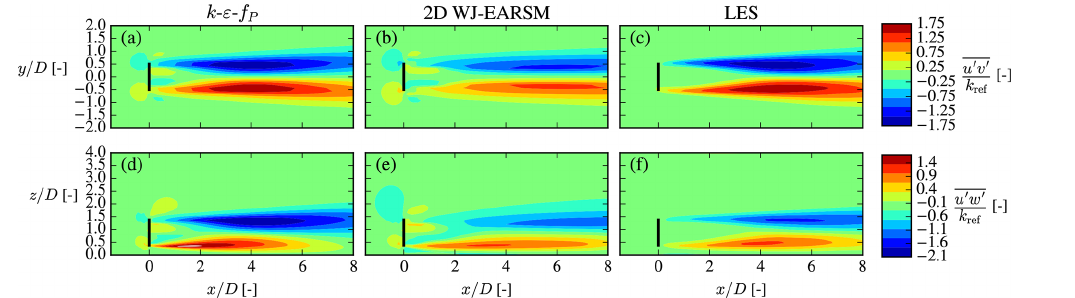
Figure 18. Lateral U momentum flux at hub height x – y plane (a–c) and vertical U momentum flux at the center x – z plane (d–f) for the single-wake V80